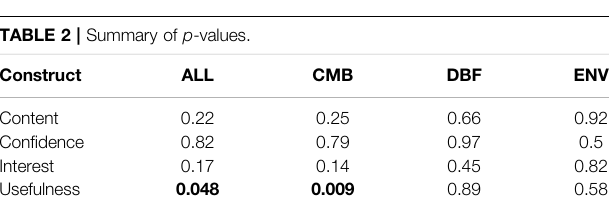
TABLE 2 | Summary of p